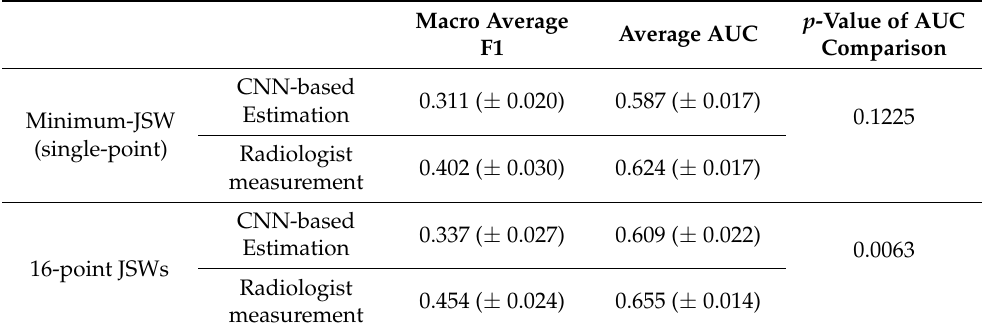
Table 2. KL-grade classification performance using minimum-JSW and 16-point JSWs from the radiologist measurements or CNN-based estimation using XGBoost model. The error represents the 95% confidence interval with a p -value of the t -test reported for comparison between CNN-based estimation and radiologist measurements.